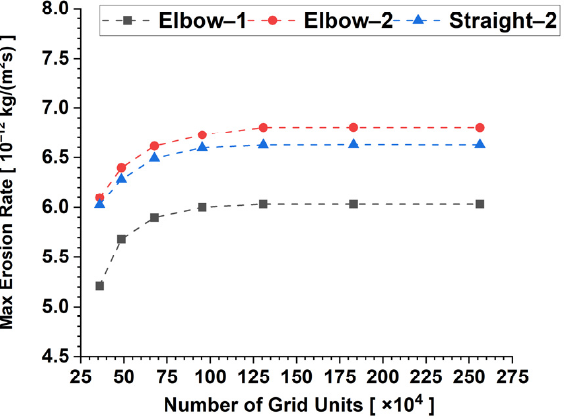
Figure 2. Max erosion rate of Elbow-1, Elbow-2, and Straight-2 with different grid numbers. Table 3. Research Data for the location of the maximum erosion zone at Elbow-1.